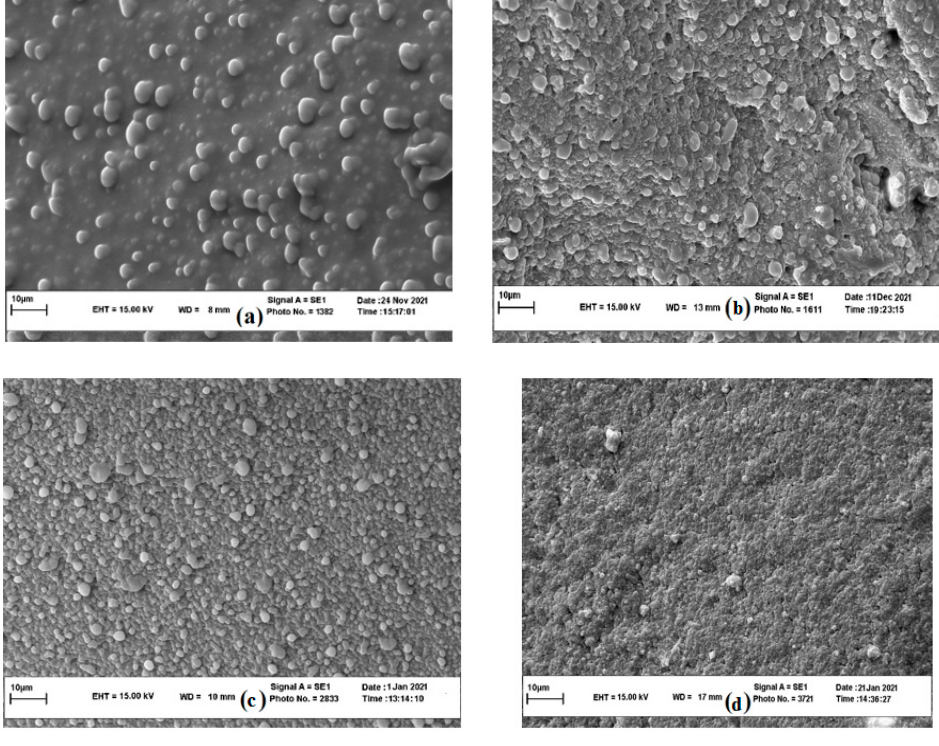
Figure 5. SEM images of UF Feta-type cheese at 3 ( a ), 20 ( b ), 40 ( c ), and 60 ( d ) days of storage. Table 8. The relationship between SEM image texture indices and instrumental mechanical characteristics of UF Feta-type cheese.